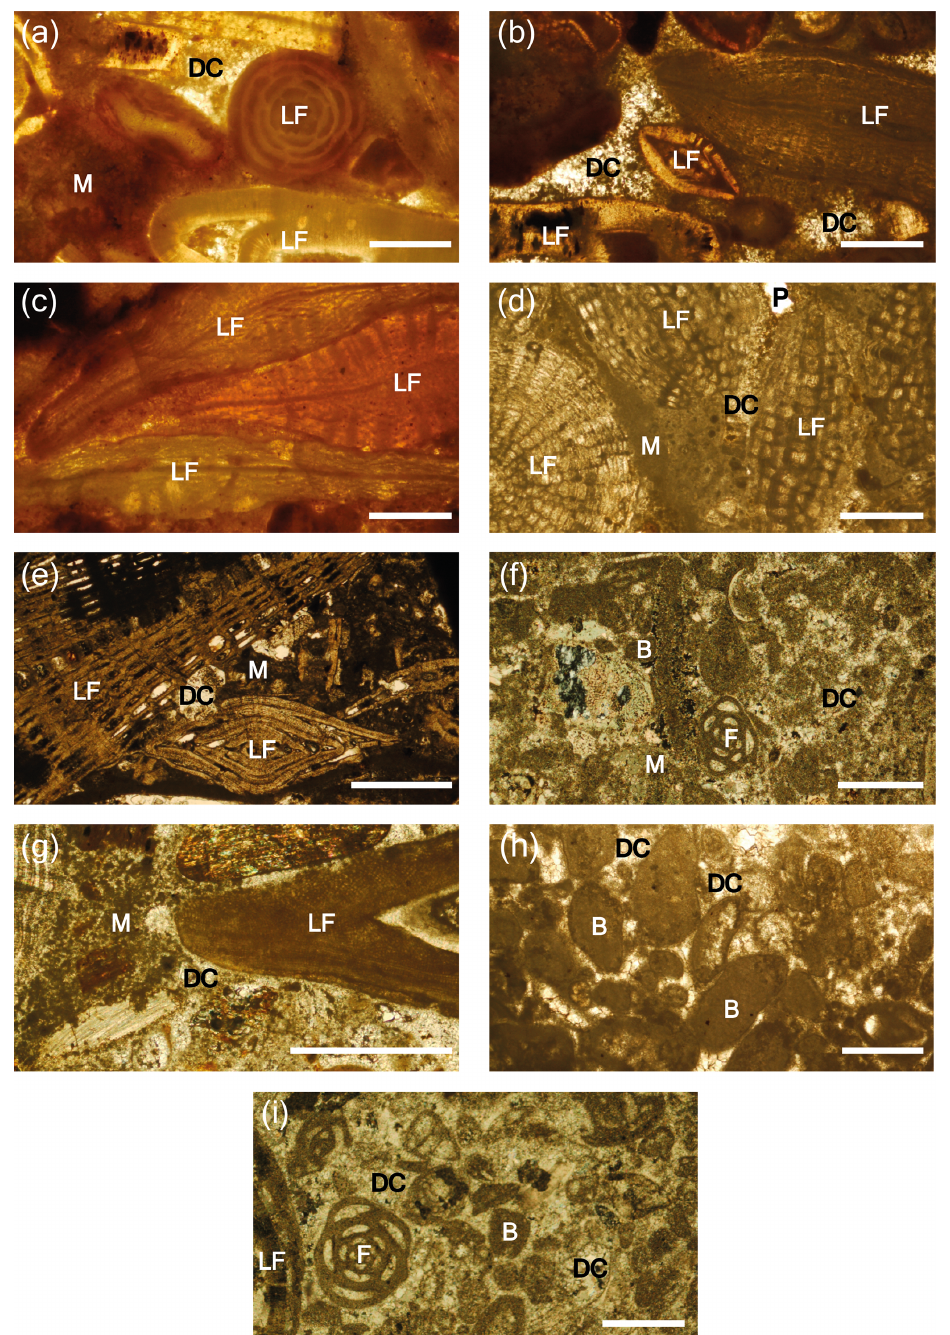
Figure 3. Example thin section images of the bulk samples showing the range of biota and amount and type of cement. Images taken with transmitted light microscope; XPL stands for crossed polarised light, and PPL stands for plane polarised light. White scale bars are 500µm in each image. (a) LF packstone (? Alveolina and nummulitids) with quartz grains within a clay matrix (sample K05 in XPL). (b) LF packstone (nummulitid and orthophragmine) with quartz grains within a clay matrix (sample K09 in PPL). (c) LF packstone–grainstone (orthophragmine) with quartz grains within a clay matrix (sample K16 in PPL). (d) LF packstone (miogypsinids and Sphaerogypsina ) with thin calcitic meniscus cement (sample L05 in PPL). (e) LF packstone ( Lepidocyclina and nummulitid) with calcite cement, clay matrix and quartz grains (sample LCL in PPL). (f) Bioclastic wackestone with secondary calcite cement (sample JB1 in XPL). (g) Bioclastic wackestone with secondary calcite cement (sample JB3 in XPL). (h) Bioclastic grainstone with secondary calcite cement (sample JF2 in PPL). (i) Foraminifera wackestone with secondary calcite cement (sample JH1 in XPL). LF stands for larger foraminifera, DC stands for diagenetic cement, M stands for matrix sediment, P stands for porosity, F stands for foraminifera and B stands for other bioclast. Further sample descriptions can be found in Table